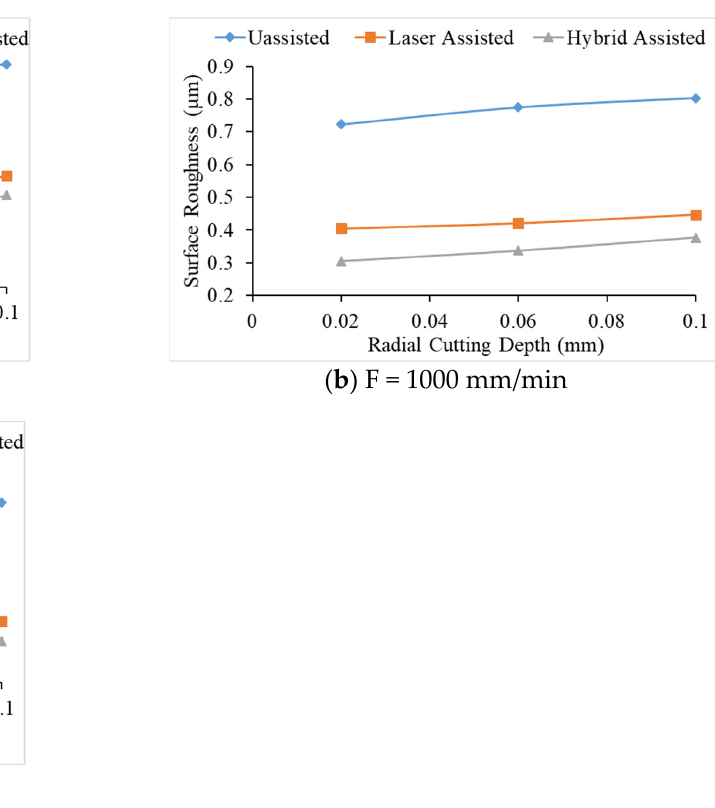
Figure 4. Surface roughness comparison chart with the three kinds of assistance using the Taguchi method.